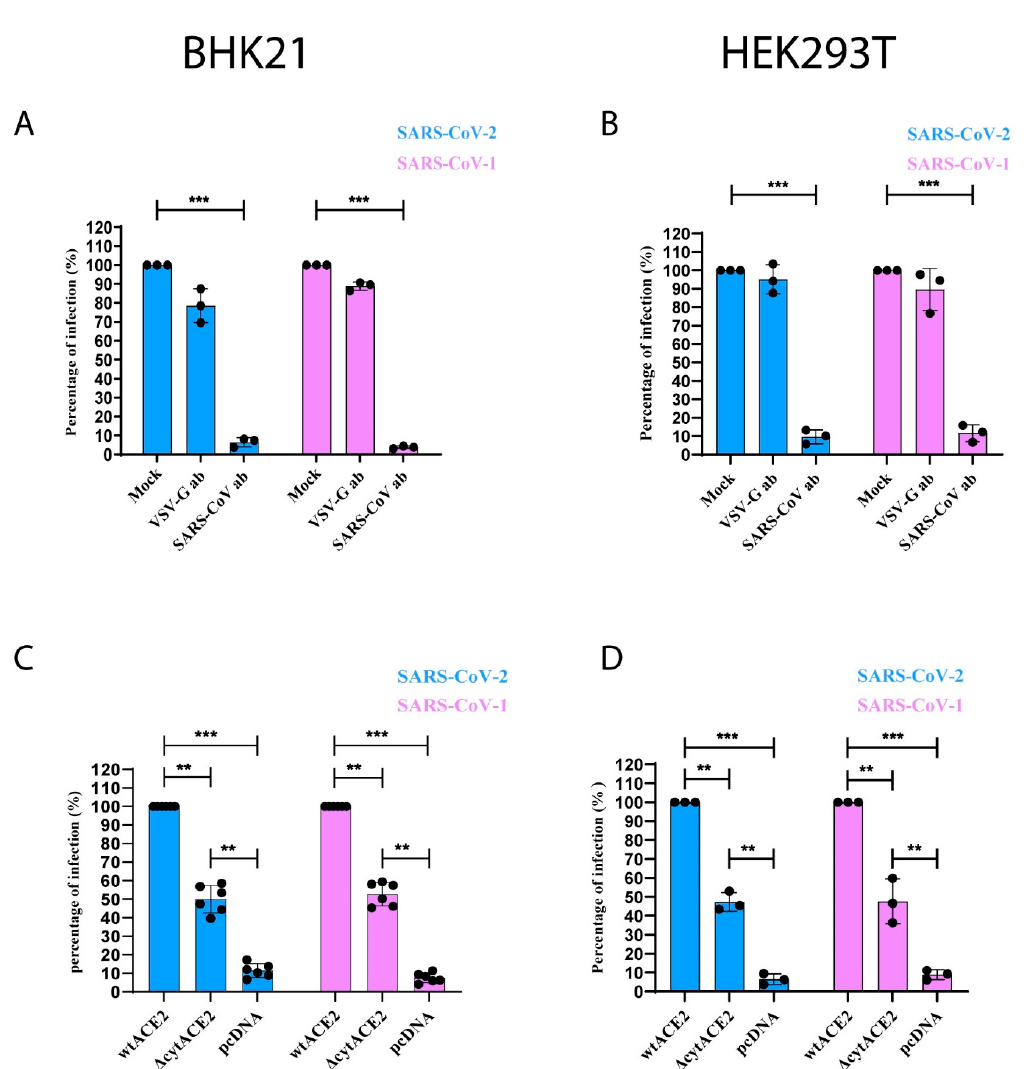
Figure 7. ACE2 cytoplasmic domain is not necessary for SARS-CoV-1 and -2 infection. ( A , B ) The presence of matured SARS-CoV-1 and -2 PVs were confirmed by neutralization assay using either SARS-CoV or VSV-G antibodies in wtACE2- expressing BHK21 or HEK293T cells. Pseudotyped SARS-CoVs were treated with SARS-CoV or VSV-G antibodies for 1 h followed by infection of BHK21 (left) or HEK293T (right) cells. ( C , D ) BHK21 and HEK293T cells were transfected with either wtACE2 or ∆ cytACE2 receptors. Twenty-four hours post-transfection, cells were infected with pseudotyped SARS-CoVs for 1 h and infection of PVs was detected by counting GFP-positive cells. Mock in each condition refers to untreated/non-transfected cells. The graphs represent data from at least three independent experiments. Data are shown as mean ± SD. p -value was determined by one-way ANOVA analysis (** p < 0.01; *** p <